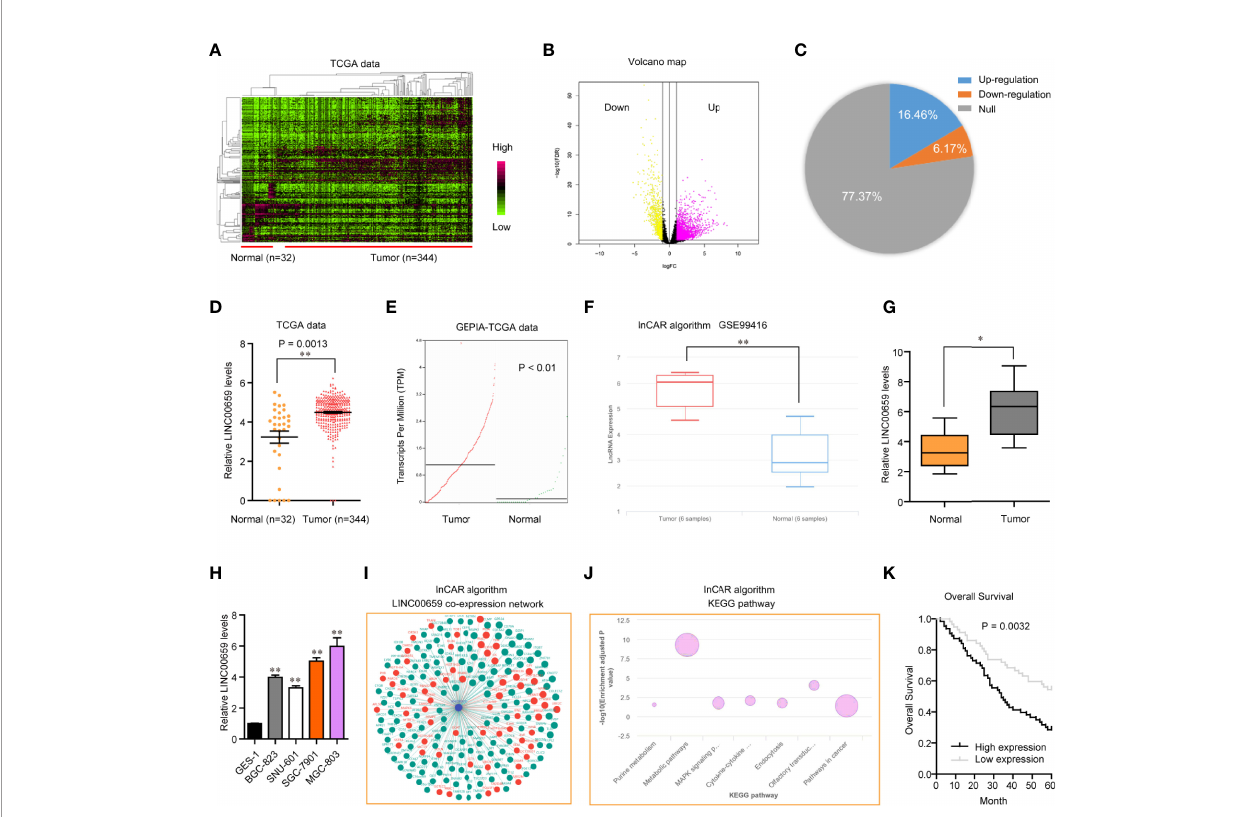
FIGURE 1 | LINC00659 was highly expressed in GC and relevant with poor prognosis. (A) Heatmap of TCGA data analysis. (B) Volcano map. (C) The percentages of up- or down-regulated lncRNAs in GC tumor samples. (D) LINC00659 expression in GC tumor and normal samples using TCGA data. (E) LINC00659 expression using “ GEPIA ” algorithm analysis. (F) “ lnCar ” algorithm analyzed LINC00659 expression using GSE99416 data. (G) qPCR measured LINC00659 expression in 120 GC tissues. (H) qPCR measured LINC00659 levels in GC cell lines. (I) “ lnCar ” algorithm analyzed the co-expression network of LINC00659. (J) “ lnCar ” algorithm analyzed the KEGG pathways of LINC00659. (K) Overall survival. *P < 0.05, **P <